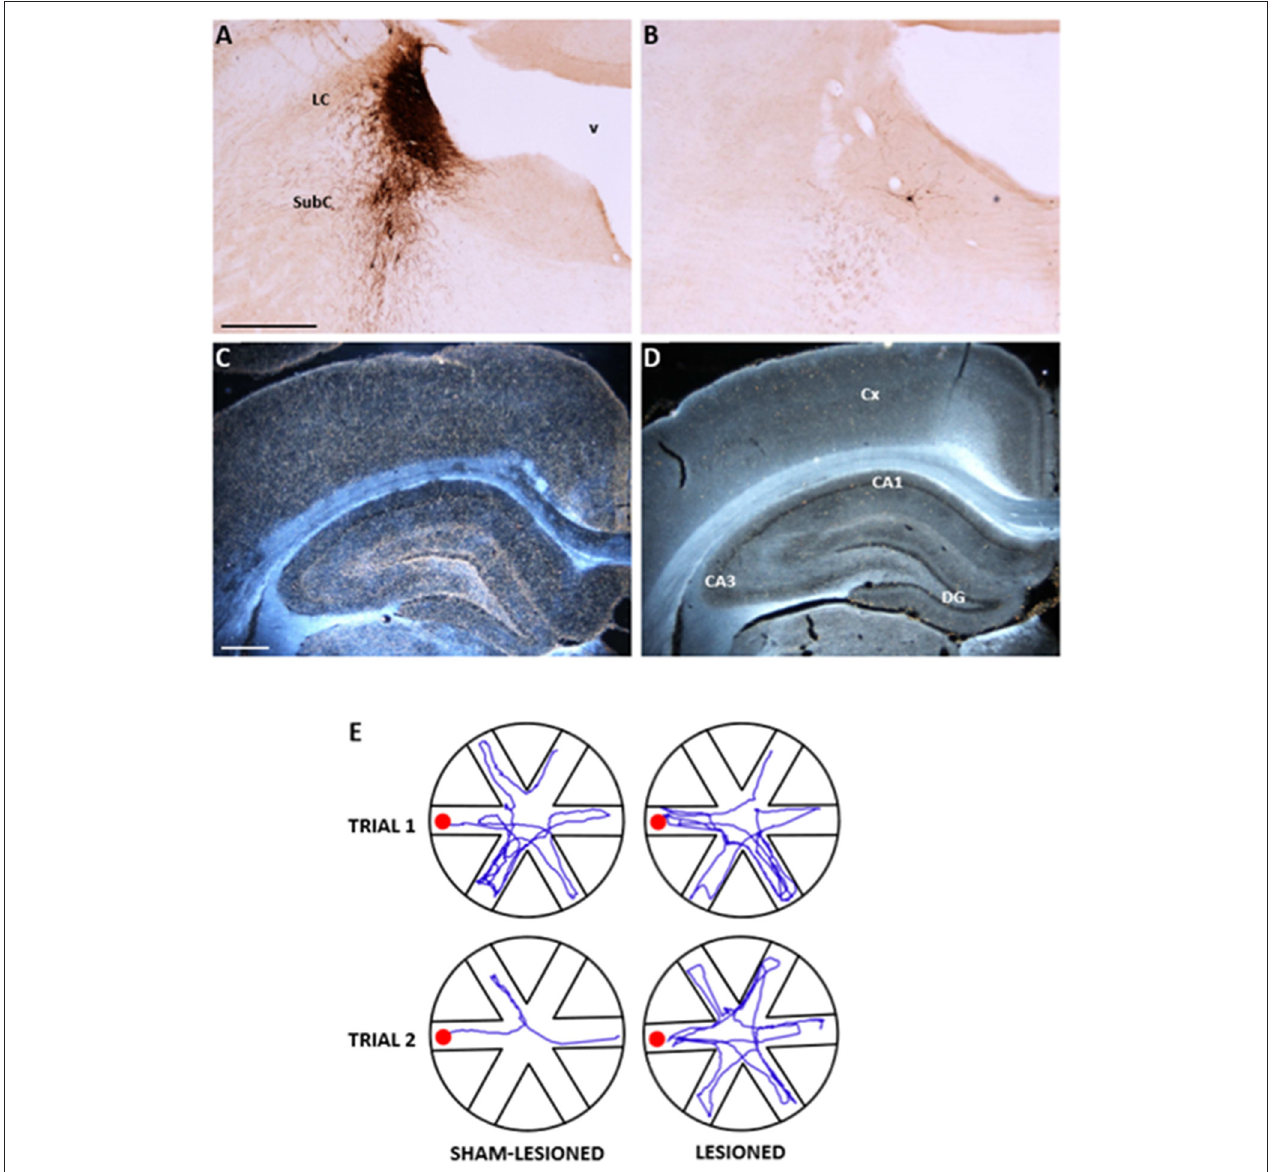
FIGURE 1 | Anatomical and functional effects of the selective noradrenergic lesion in young adult Sprague-Dawley rats. (A–D) : Photomicrographs showing the effects of the anti-DBH immunotoxin, injected bilaterally into the LC, on noradrenergic neurons in the LC/SubC (A,B) and on the DBH-immunoreactive terminal innervation in the parietal cortex and hippocampus ( C,D , in dark field). Note in (B,D) the nearly complete loss of immunoreactive neurons and fibers induced by the lesion, compared to the normal patterns in the specimens from a sham-lesioned animal (A,C) . In (E) , the actual swim paths taken by representative sham-lesioned and lesioned animals undergoing the Radial Arm Water Maze (RAWM) task for working memory are illustrated. The sham-lesioned animal rapidly learns the task and significantly improves its performance from the first to the second trial, whereas the lesioned animal does not. LC, locus coeruleus; SubC, subcoeruleus, v fourth ventricle, CA, cornu ammonis of the hippocampus; DG, dentate gyrus. Scale bars in (A,C) : 500 µ m. Adapted from Coradazzi et al. (2016).